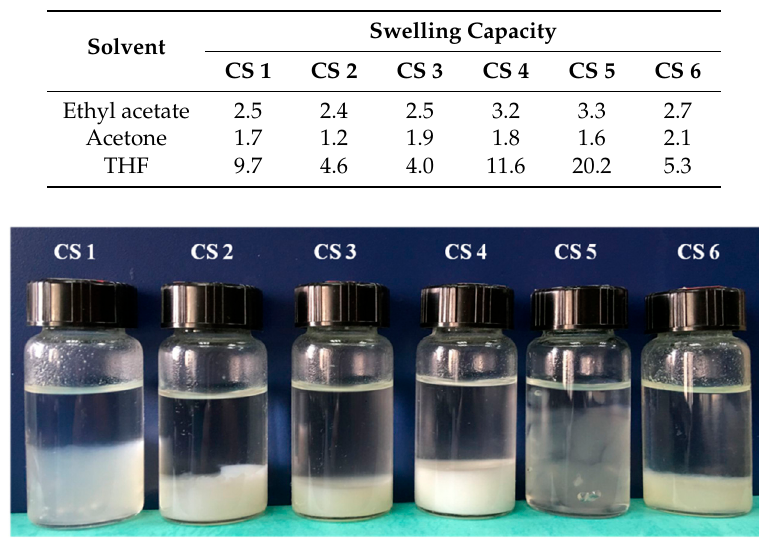
Figure 2. Swelling states of CSs 1 – 6 in THF.